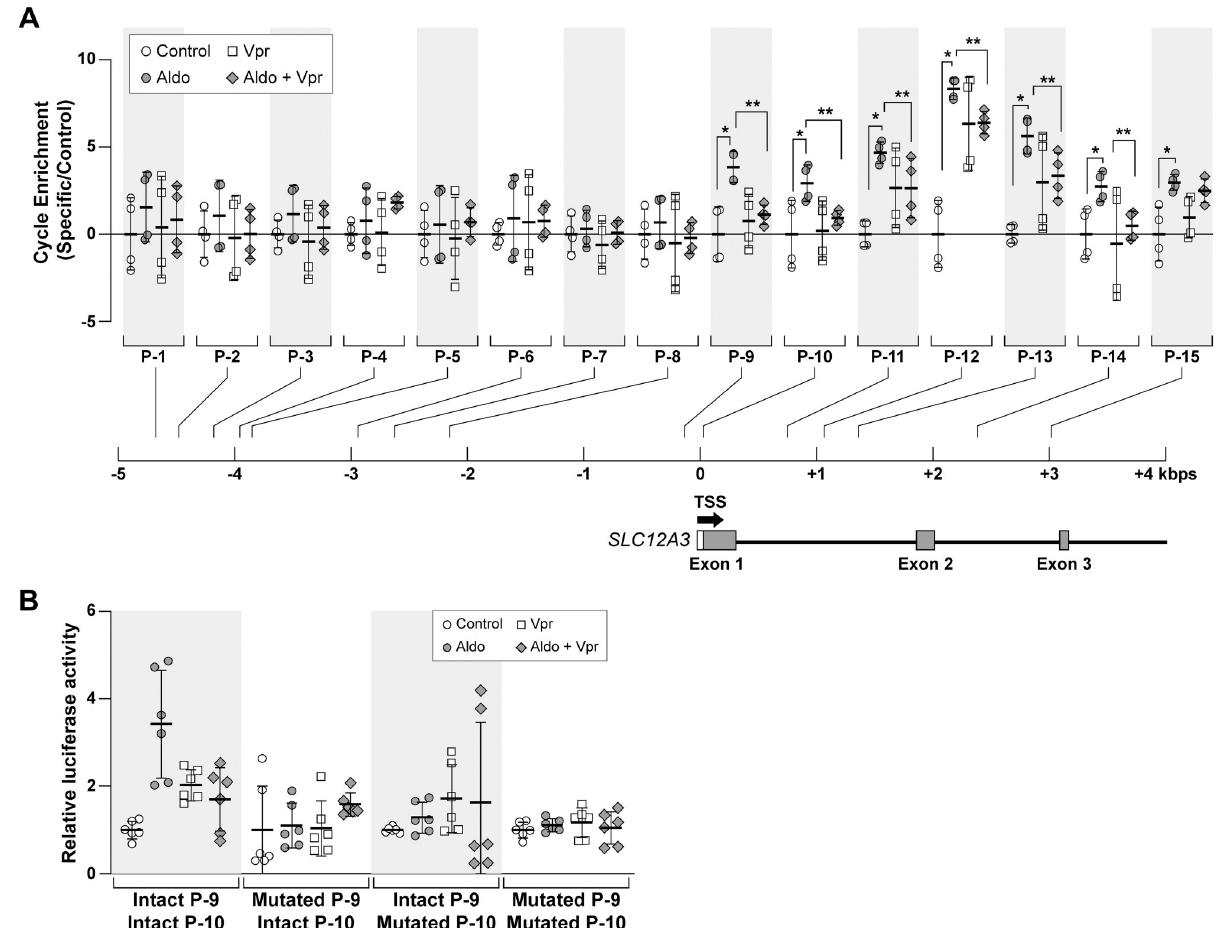
Fig 6. Characterization of putative transcription factor motifs within human SLC12A3 gene and the effect of sVpr on the association of MR to its binding regions. ( A ) Human DCT cells were exposed to aldosterone or vehicle, with or without sVpr, and were processed for the ChIP assay, using anti-FLAG antibody, targeting FLAG-MR. Fifteen primer pairs (S2 Table), located around the transcription start site of the SLC12A3 gene, encoding NCC, were used for qRT-PCR. The fold-enrichment of the specific FLAG-MR-binding DNA sequences to that of the normal rabbit anti serum control was compared among four treatment groups: Control, aldosterone, sVpr, and aldosterone plus sVpr. As shown in the column graphs, the regions of highest Vpr-specific binding (determined by the ratio of aldosterone response to Vpr response) were amplicons P-9 and P-10. � P < 0.05 aldosterone vs control; �� P < 0.05 aldosterone plus Vpr vs. aldosterone. ANOVA, Bonferroni correction. ( B ) CV-1 cells were transfected with WT or mutated SLC12A3 constructs. The construct pTSC-Luc contains one putative MR response element (MRE) motif (5’- CAATCAAATGGTGTTCTGC -3’, amplicon P-9) and one putative SP1 motif (5’- CCCTCCCTGGACACC -3’, amplicon P-10). Amplicons P-9 and P-10 exerted the largest suppressive effects by Vpr on transcriptional activity. Putative MRE and SP1 motifs flanking the SLC12A3 transcription start site were mutated with random sequences (S2 Table) to eliminate the putative regulatory motif sequences. Each reporter construct contained a fragment of the SLC12A3 gene. CV-1 cells were transfected with reporter constructs as shown and exposed to aldosterone and/or sVpr. sVpr attenuated aldosterone-stimulated reporter activity with the intact P-9 and P-10 constructs but had no effect with single or dual mutants of P-9 and P-10 amplicons. ��� P < 0.001 vs control, ANOVA, followed by Bonferroni